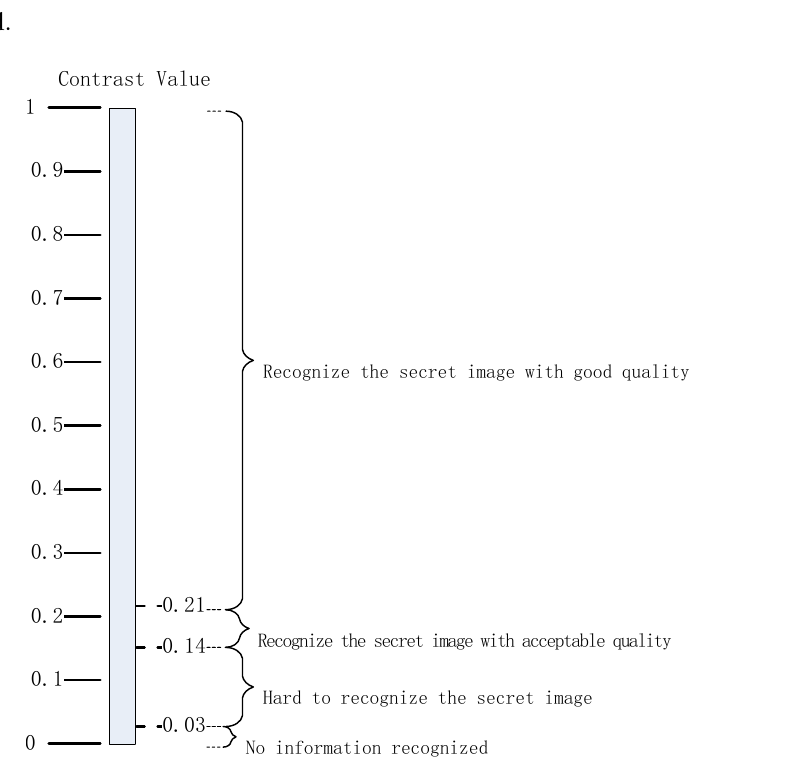
Figure 3. Contrast value and its clarity in RG-based visual cryptography